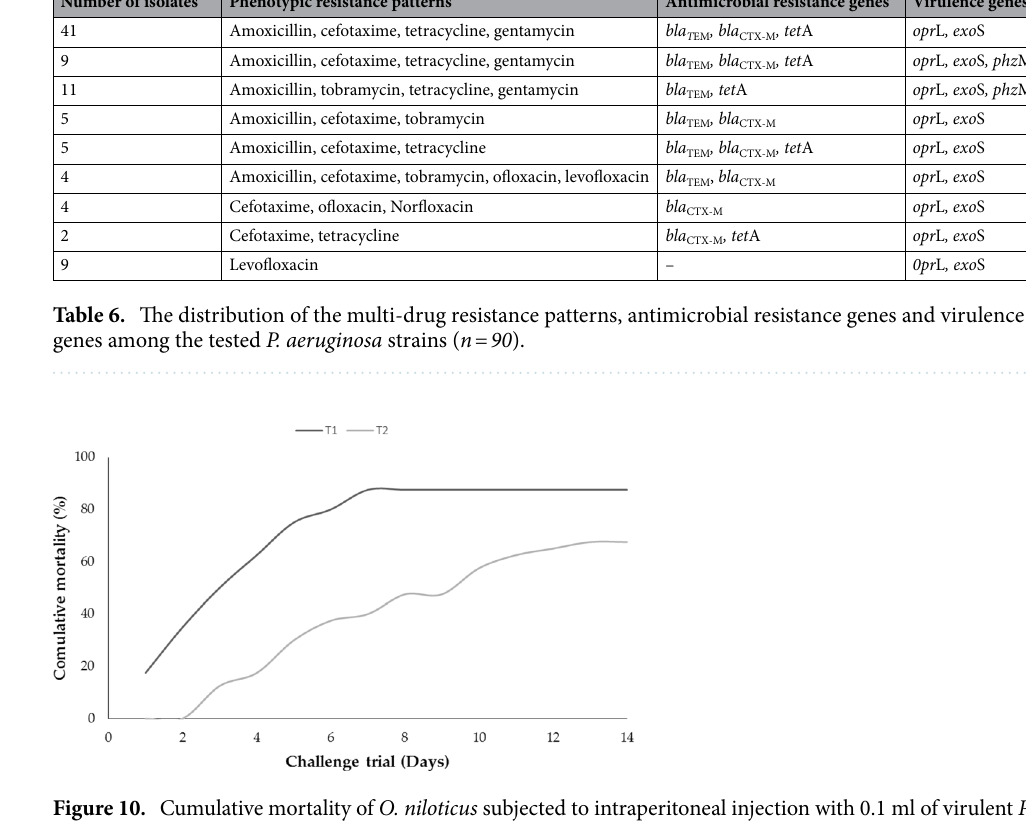
Figure 10. Cumulative mortality of O. niloticus subjected to intraperitoneal injection with 0.1 ml of virulent P. aeruginosa strain A (T1) and P. aeruginosa strain B (T2) at concentration of 3 × 10 7 cells mL -1